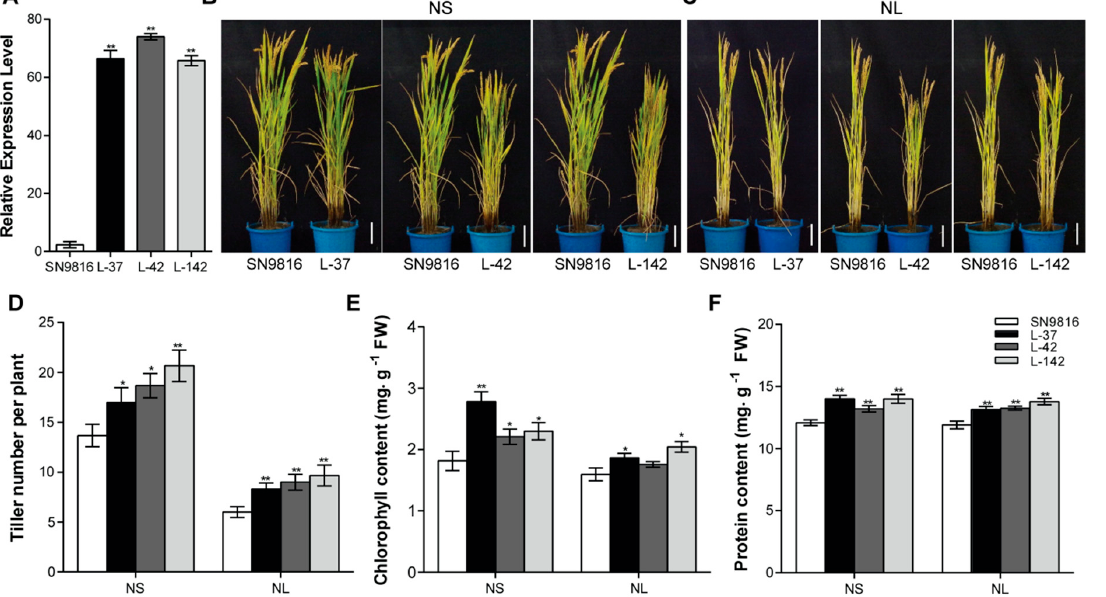
Figure 2. Characterization of 35S-OsATG8c transgenic lines. ( A ) Expression level of OsATG8c in 14-day-old seedlings of SN9816 and transgenic lines (L-37, L-42 and L-142). OsActin1 was used as an internal control. Values are the means ± SD ( n = 3). ( B , C ) Phenotypes of the whole rice plants under sufficient N (NS, 225 kg·ha − 1 ) or low N (NL, 75 kg·ha − 1 ) conditions at the grain filling stage. Scale bar: 10 cm. ( D ) The tiller number per plant, ( E ) chlorophyll content, and ( F ) protein content of SN9816 and the transgenic lines under NS (225 kg·ha − 1 ) and NL (75 kg·ha − 1 ) conditions. Values are the means ± SD ( n = 12), * p < 0.05, ** p < 0.01 ( t -test).